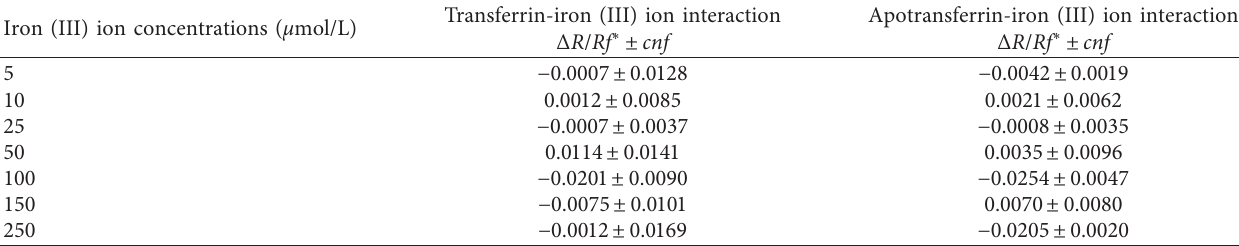
Table 2: Average Δ R / Rf values and their confidence intervals ( cnf ) for transferrin- and apotransferrin-iron (III) interactions at different iron (III) ion concentrations. Iron (III) ion concentrations ( μ